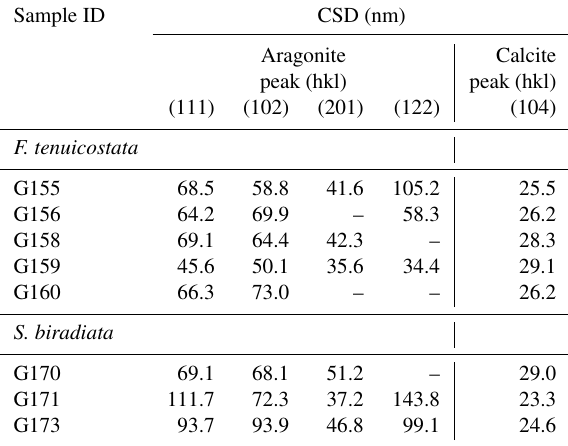
Table 2. The aragonite and calcite crystallite size (coherently scat- tering domain, or CSD) in nm, estimated using the Scherrer equa- tion (Cullity and Weymouth, 1957) with K = 0 . 9 on four main diffraction peaks of aragonite and the peak (104) of